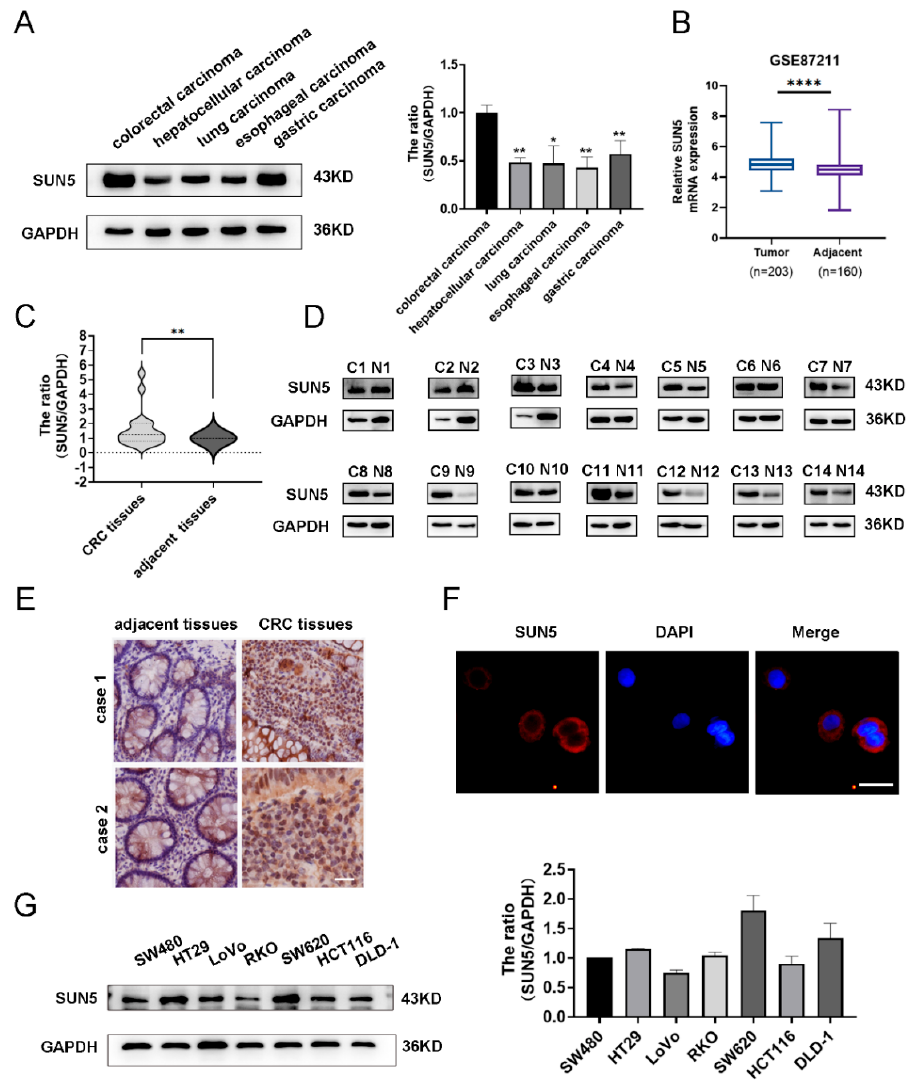
Figure 1. High expression of SUN5 was detected in colorectal cancer tissues and cells. ( A ) SUN5 protein levels in colorectal carcinoma, hepatocellular carcinoma, lung carcinoma, esophageal carcinoma, and gastric carcinoma (measured by Western blotting, * p < 0.05, ** p < 0.01). ( B ) The expression of SUN5 in 203 CRC tissues and 160 adjacent nontumor tissues according to GSE87211 cohort (**** p < 0.0001. Student’s t -test). ( C ) SUN5 protein levels in CRC tissues compared with those in adjacent tissues ( n = 40, measured by Western blotting, ** p < 0.01). ( D ) Western blotting results of protein levels of SUN5 in colorectal cancer tissues and adjacent tissues in 14 cases; the “C” represents CRC tissues, and the “N” represents adjacent tissues. ( E ) Representative IHC images of SUN5 in human CRC tissues (right) and adjacent tissues (left). Scale bar: 30 μ m. ( F ) Immunofluorescence staining results showed that SUN5 was mainly distributed in the nucleus membrane and perinuclear cytoplasm in DLD-1 cells. Scale bar: 20 μ m. ( G ) SUN5 protein levels in CRC cell lines (SW480, HT29, LoVo, RKO, SW620, HCT116, and DLD-1) were analyzed by Western blotting.